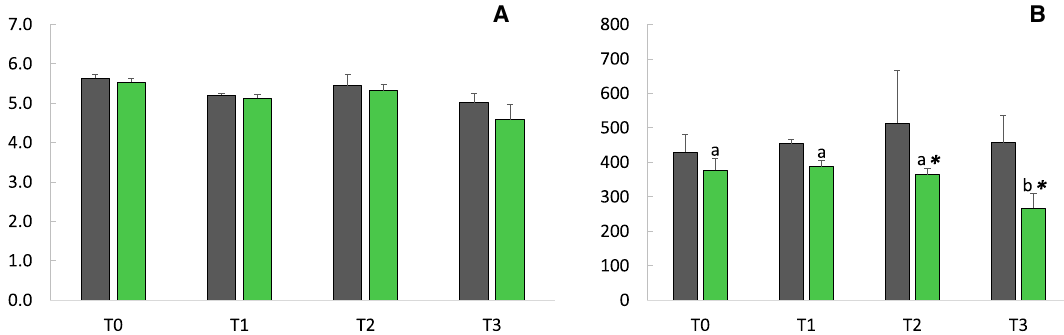
Figure 4. Alpha diversity indexes: ( A ) Shannon index mean values and ( B ) observed diversity at the beginning of the incubation (T0) and after 7 (T1), 14 (T2) and 30 (T3) days. Gray color, control (non OPE- spiked sediments); Green color, OPE-spiked sediments; * and letters: differences between treatments and time differences, respectively (p <